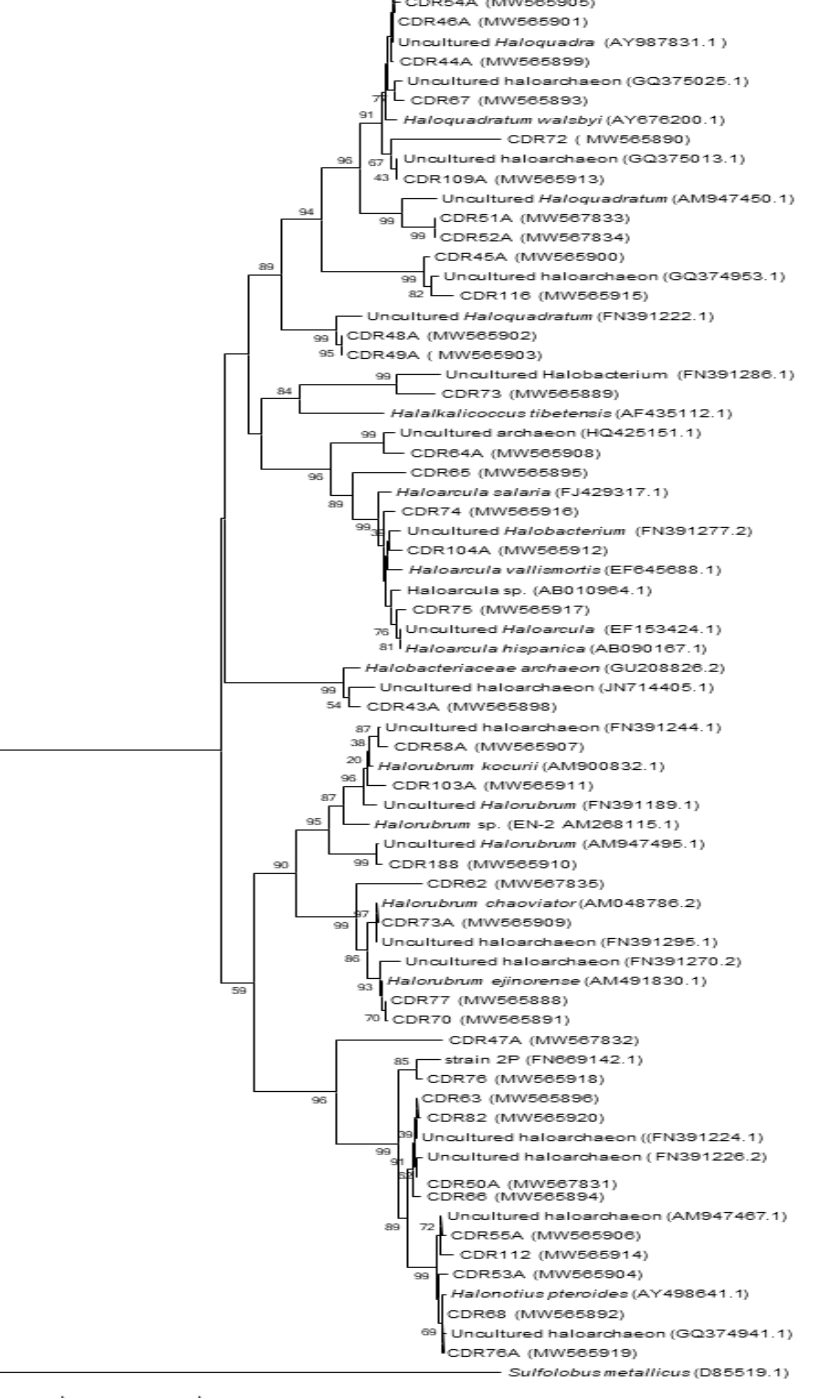
Figure 4. Neighbor-joining tree showing relationships among CDR clones’ and their closest relatives retrieved from RDPII database. Evolutionary distances were calculated using the method of maximum composite likelihood and the topology was inferred using the neighbor-joining method using MEGA 6 software. Numbers on the nodes present % bootstrap values based on 1000 replicates. Scale bar represents 0.05 substitutions per site. The 16S rRNA gene sequence of Sulfolobus metallicus was arbitrarily chosen as the outgroup to define the root of the tree. Accession number of sequences are shown in